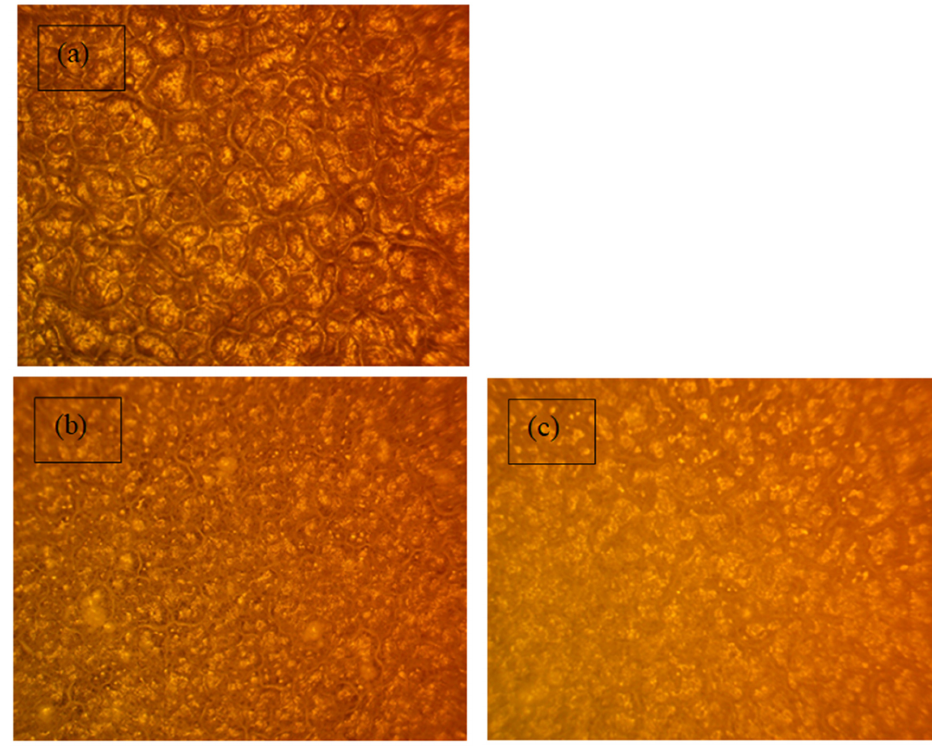
Figure 14. Optical microscopy images for ( a ) Pure PEO, ( b ) NCP-1, and ( c ) NCP-2 composite films.